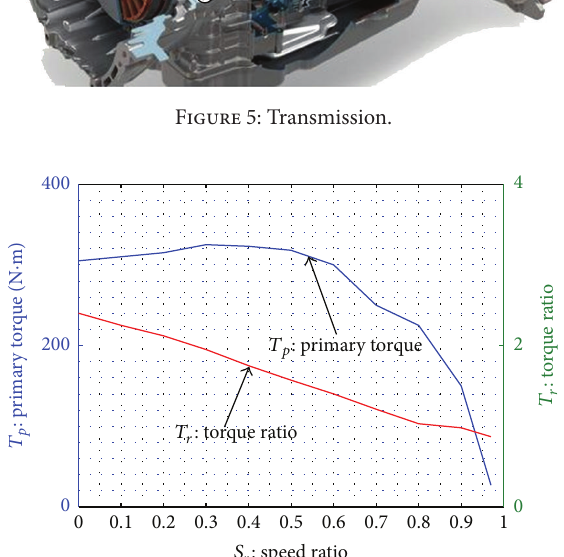
Figure 6: Torque converter